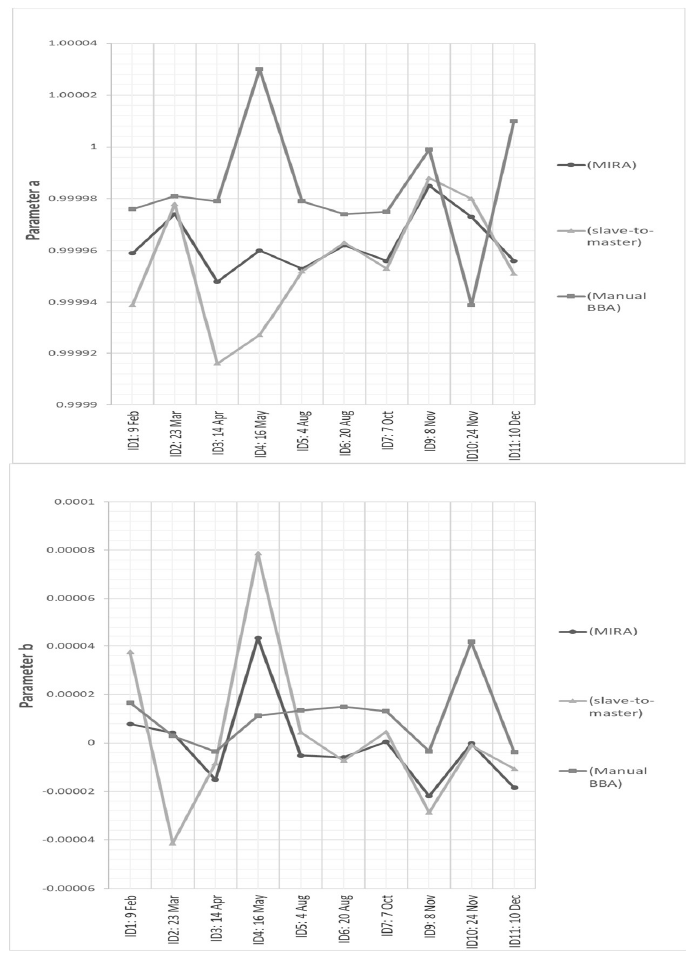
Figure 9. Comparison between the estimated parameters for all the images of ‘Multan’ dataset (band TM3) obtained by using MIRA and other methods: ‘slave-to-master’ (see Section 3.2.1) and ‘Manual BBA’ (see Section 3.2.2). For parameters a and b the values obtained from three different experiments are shown. Remote Sens. 2018 , 11 , x FOR PEER REVIEW